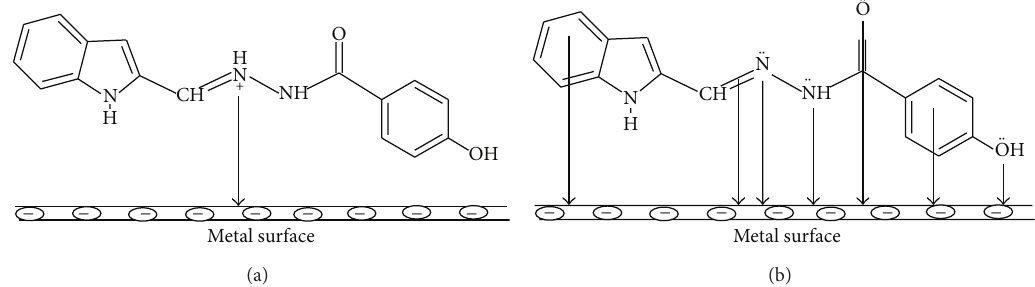
Figure 9: Adsorption of HIBH on the mild steel surface through (a) electrostatic interaction and (b) electron pair interaction.